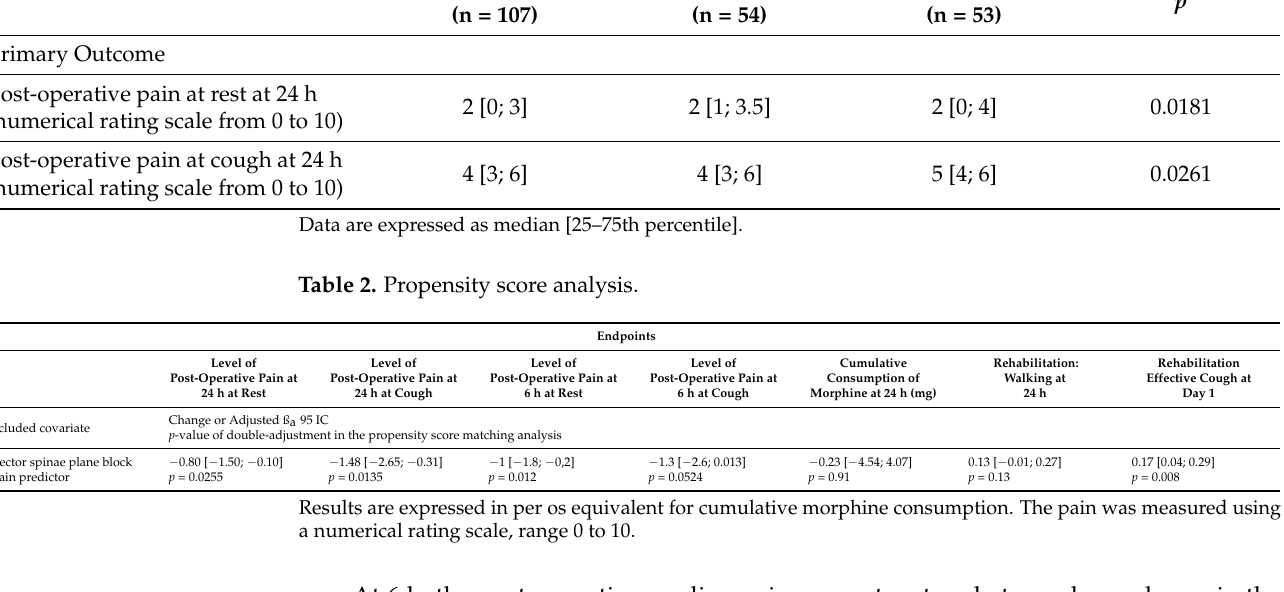
Table 2. Propensity score analysis.